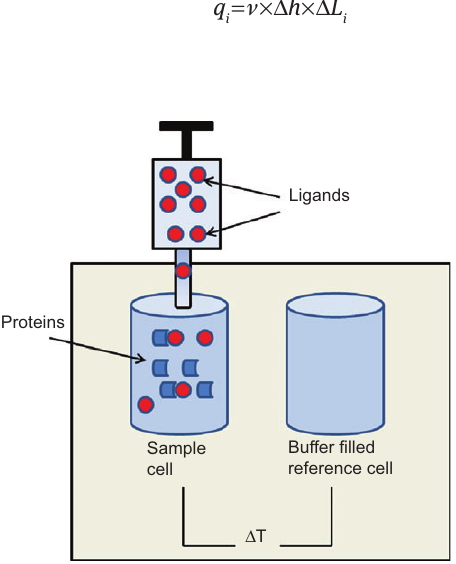
Figure 5 An isothermal calorimetry experiment. A sample cell is filled with protein (blue) solution, while the syringe is filled with ligand (red). At specific time intervals, the ligand is added to the sample cell, resulting in protein-ligand binding. This binding can be detected by temperature changes in the sample cell, as compared with the temperature in the controlled reference cell. The energy needed to keep the two cells the same temperature is detected and used to define the kinetic parameters of the ligand-protein